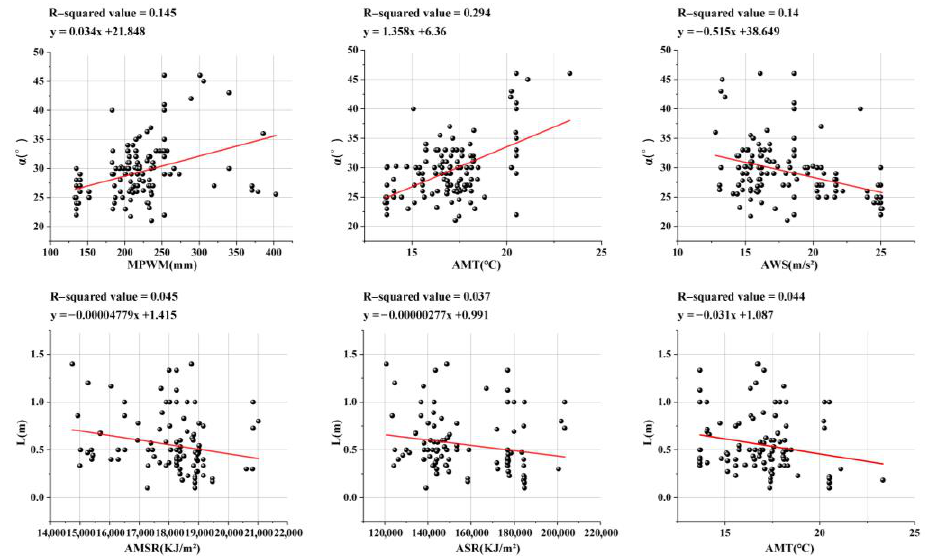
Figure 4. Linear fit to one − to − one